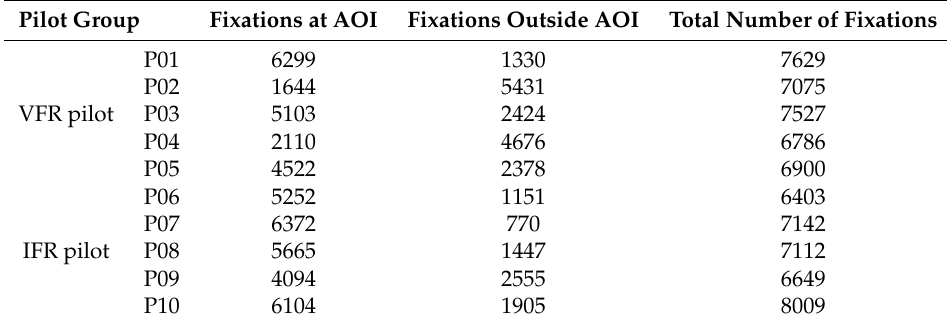
Table 5. Number of fixations with distinguished area of